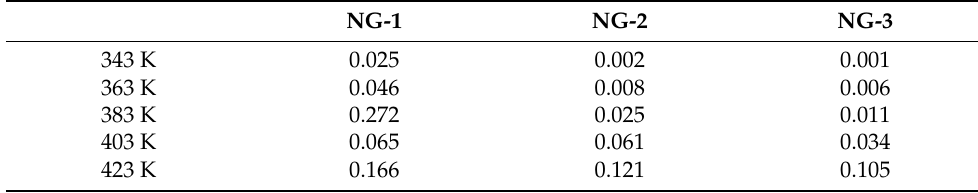
Table 4. Diffusion coefficient of water molecules in the three groups of models.